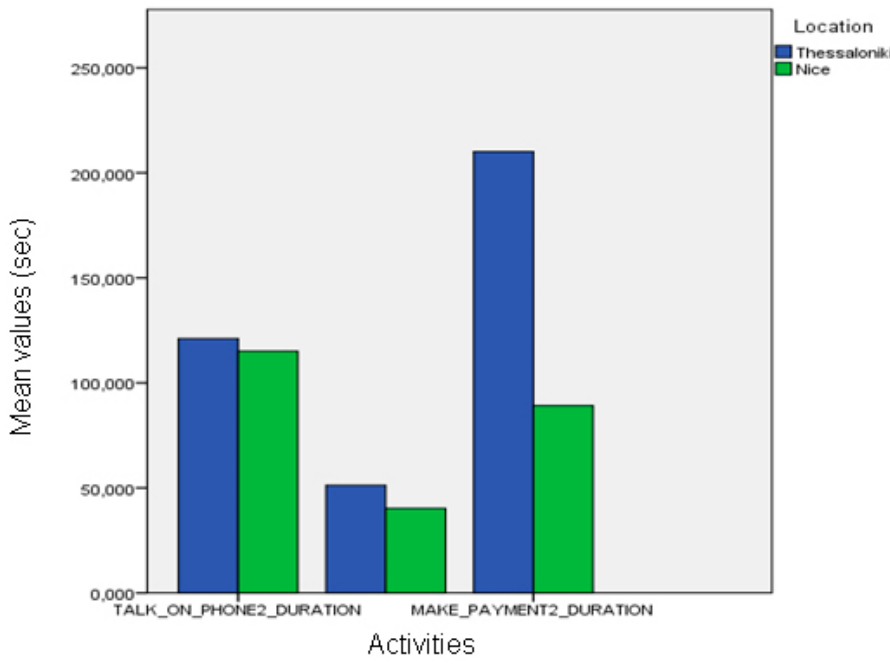
Figure 14. Comparison between the frequencies of the automatic event recognition between the two sites.